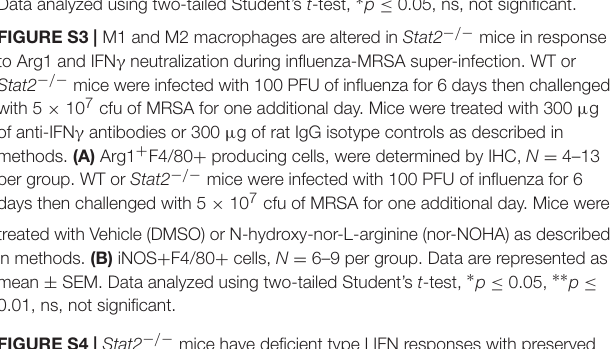
FIGURE S4 | Stat2 − / − mice have deficient type I IFN responses with preserved type II IFN responses. (A) WT and Stat2 − / − male 6–8 weeks mice were infected with 100 PFU of influenza A/PR/8/H1N1 by oropharyngeal aspiration for 6